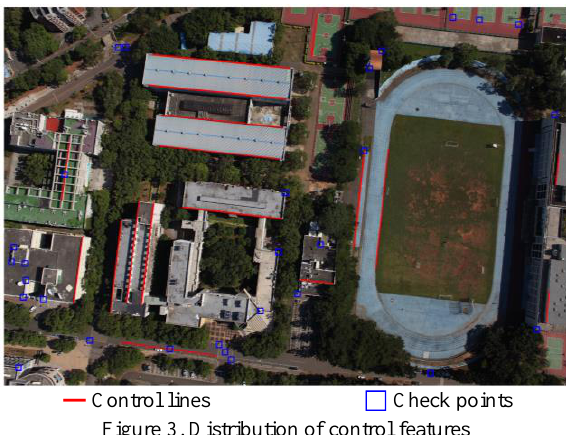
Figure 3. Distribution of control features